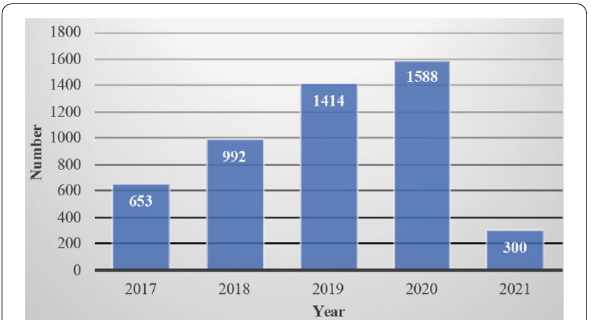
Figure 2 Relationship between the number of published papers and publication years covering the last five years (as of March 2021). The basic descriptor is \TI ((AI OR artificial intelligence OR machine = learning OR support vector machine OR SVM OR data-driven OR deep OR autoencoder OR convolutional network* OR neural network*) AND (fault detection OR fault isolation OR fault diagnosis